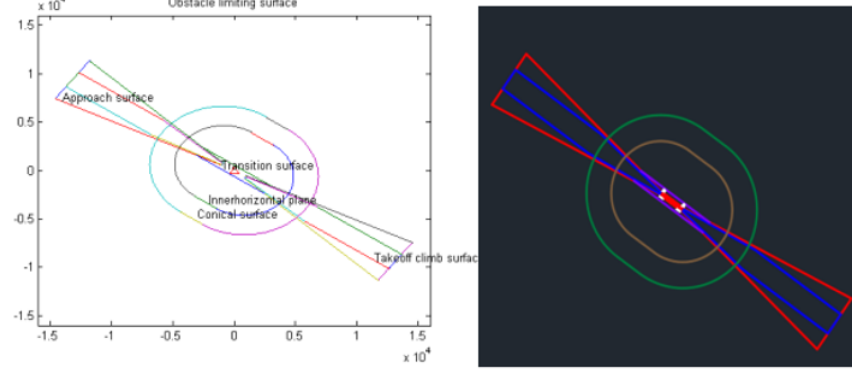
Fig. 2. Comparison of obstacle restriction